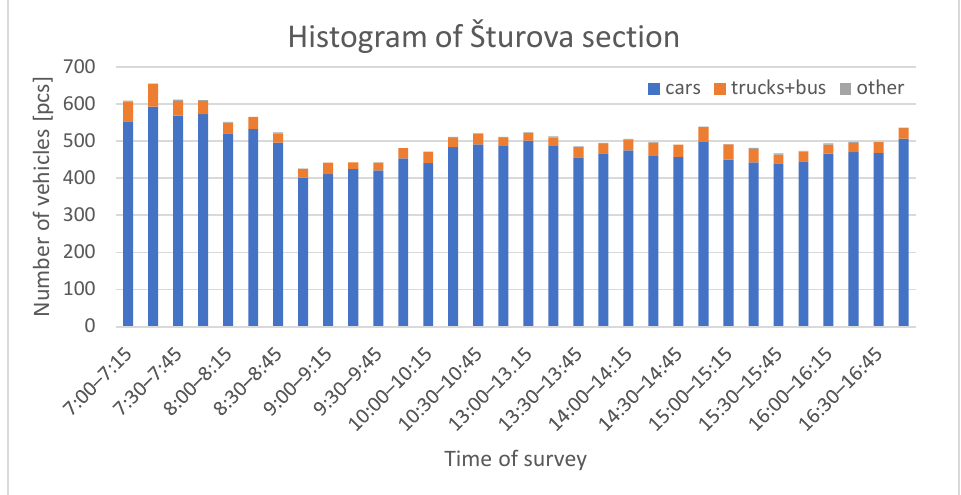
Figure 4. Histogram of Sturova section (source elaborated by authors).